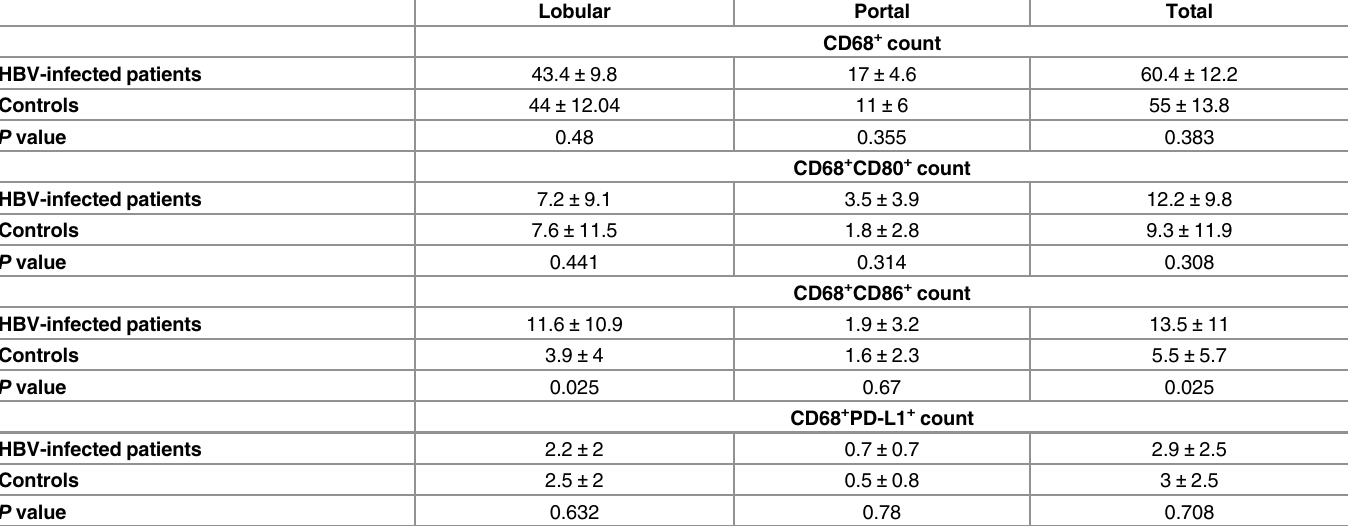
Table 2. Counts of CD68 + cells, CD68 + CD80 + cells, CD68 + CD86 + cells and CD68 + PD-L1 + cells. The average count ± S.D. for each areas of the liver is represented as indicated. The p value indicates the significance of differences between HBV-infected and control